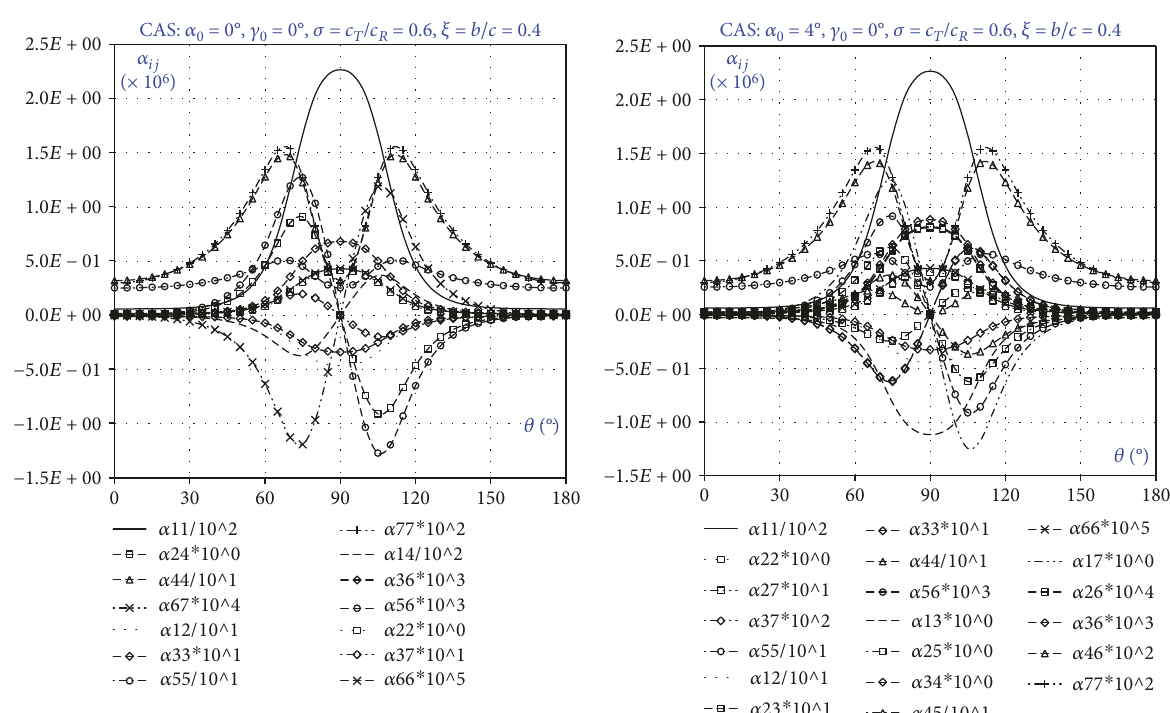
= a ij ji vs. ply angle of Model A for